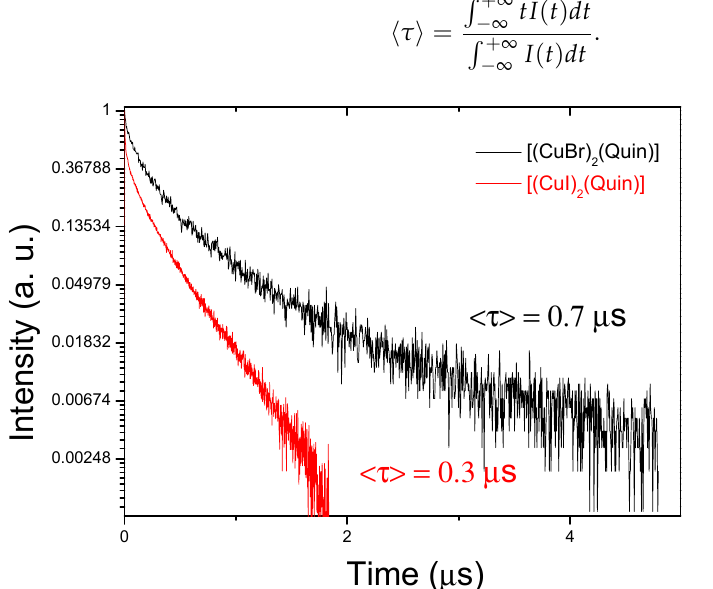
Figure 13. Decaycurvesof[(CuBr) 2 (Quin)](red)and[(CuI) 2 Figure 13. Decay curves of [(CuBr) 2 (Quin)] (red) and [(CuI) 2 (Quin)] (black) obtained at ambient conditions.